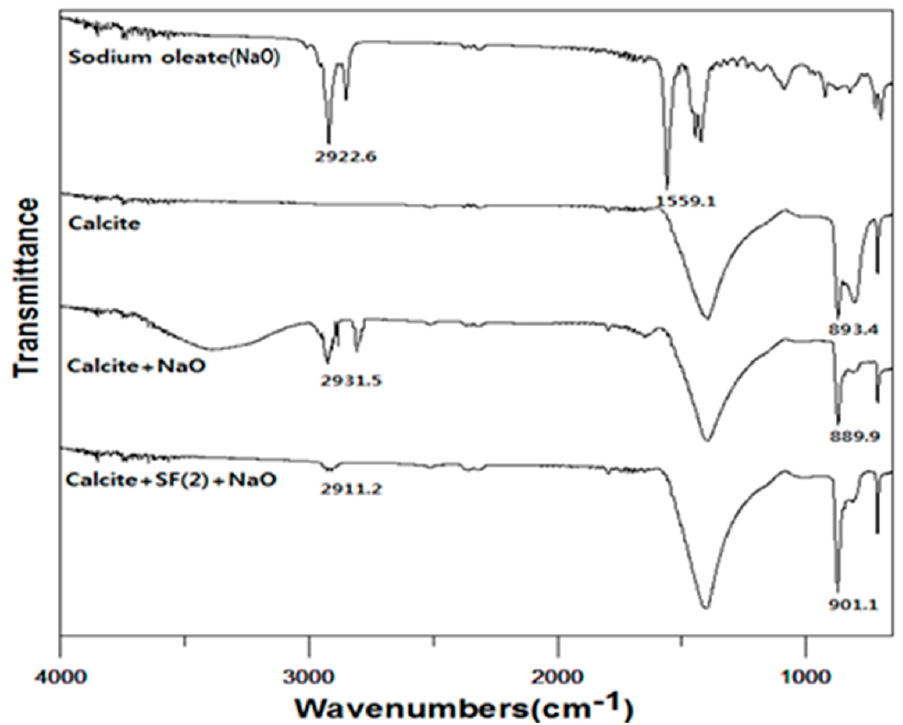
Figure 10. FTIR analysis result of calcite at the optimum flotation conditions.